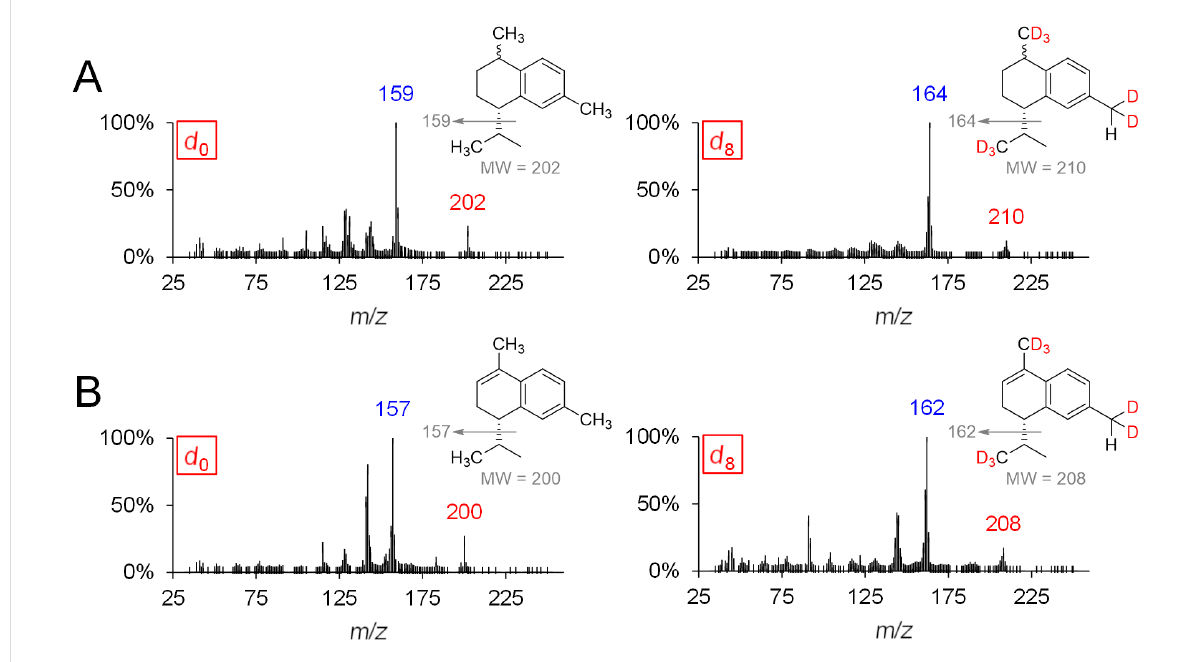
Figure 7: MS spectra and expected labeling patterns of genuine and deuterium-labeled A: calamenene (isomer) and B: α -calacorene after feeding ex- periments using d 3 -MVL.